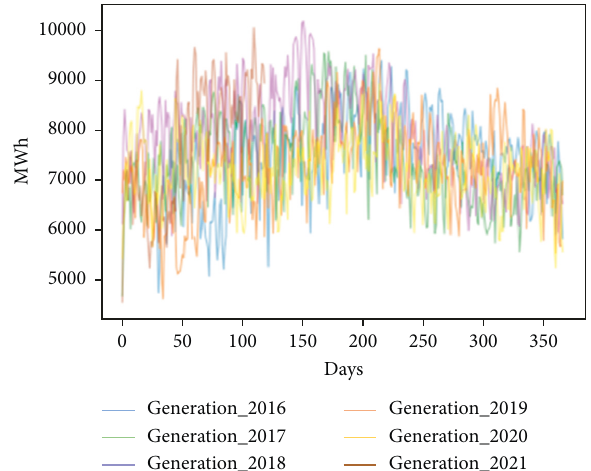
Figure 2: Graph of energy generation data by